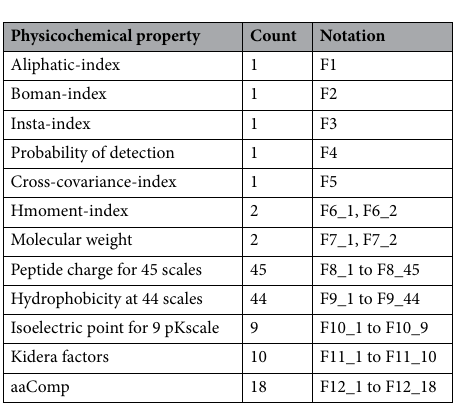
Table 1. Amino acid physicochemical properties used.